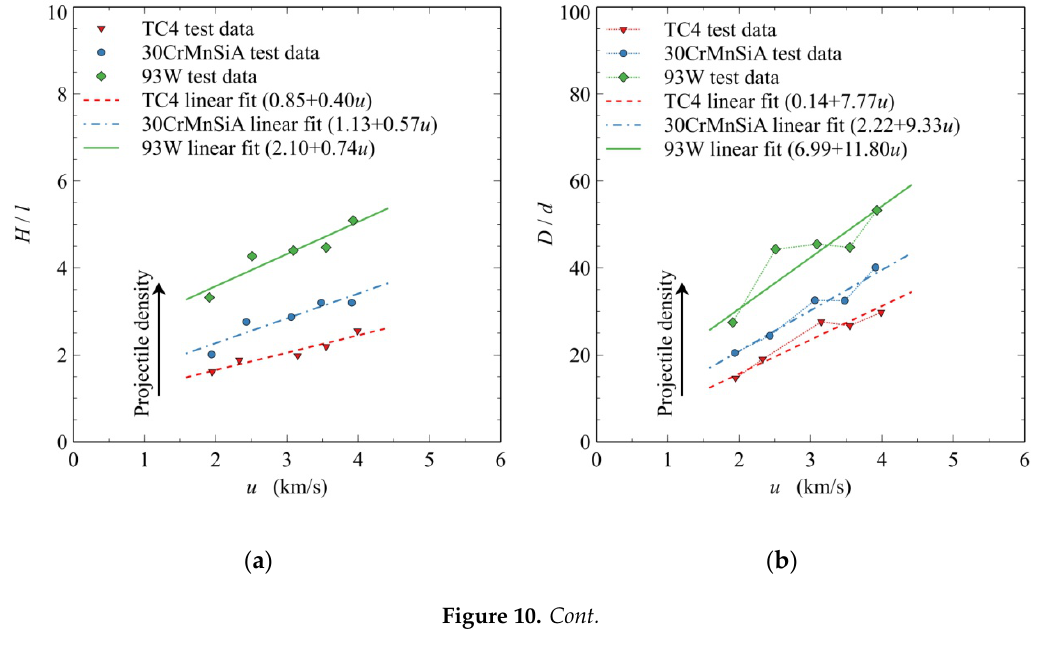
( d ) Figure 10. The influences of the impact velocity on crater depth, diameter, volume, and crater H / D ratio: ( a ) dimensionless crater depth versus impact velocity; ( b ) dimensionless crater diameter versus impact velocity; ( c ) dimensionless crater volume versus impact kinetic energy; ( d ) crater H/D ratio versus impact velocity. 4.2. Influences of Projectile–Target Ratio Figure 11 presents the influences of the projectile–target ratio on the dimensionless crater depth, diameter, volume, and the crater H / D ratio. The dimensionless crater depth, diameter, and volume increase with the increase of ρ p / ρ t , as shown in Figure 11a–c. These three dimensionless crater parameters positively correlate with ρ p / ρ t . The crater H / D ratio increases slightly (the slope is only 0.0041) with the increase of ρ p / ρ t , as shown in Figure 11d. This implies that the positive correlation between the H / D ratio and the ρ p / ρ t